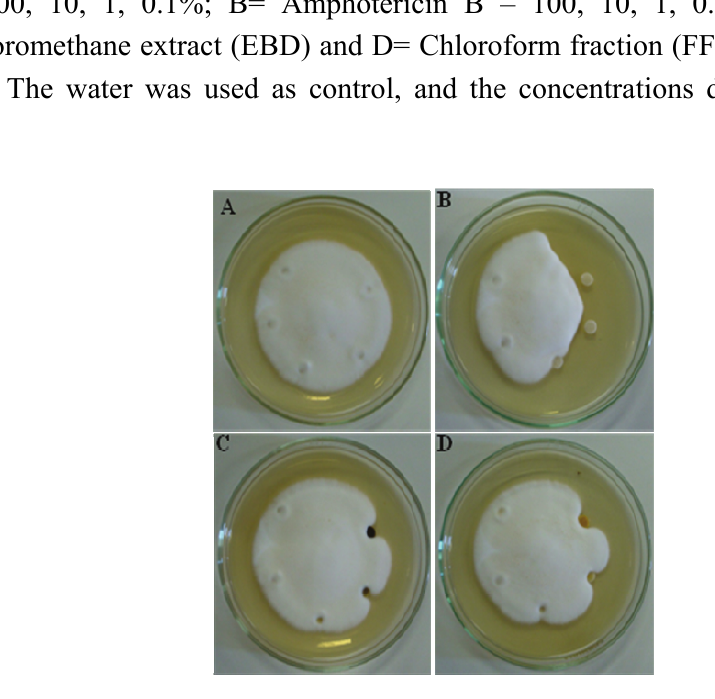
Figure 1. Antifungal active in solid medium against T. rubrum . A= Negative control – DMSO 100, 10, 1, 0.1%; B= Amphotericin B – 100, 10, 1, 0.1 µg/mL and water. C= Dichloromethane extract (EBD) and D= Chloroform fraction (FF) – 1000, 100, 10